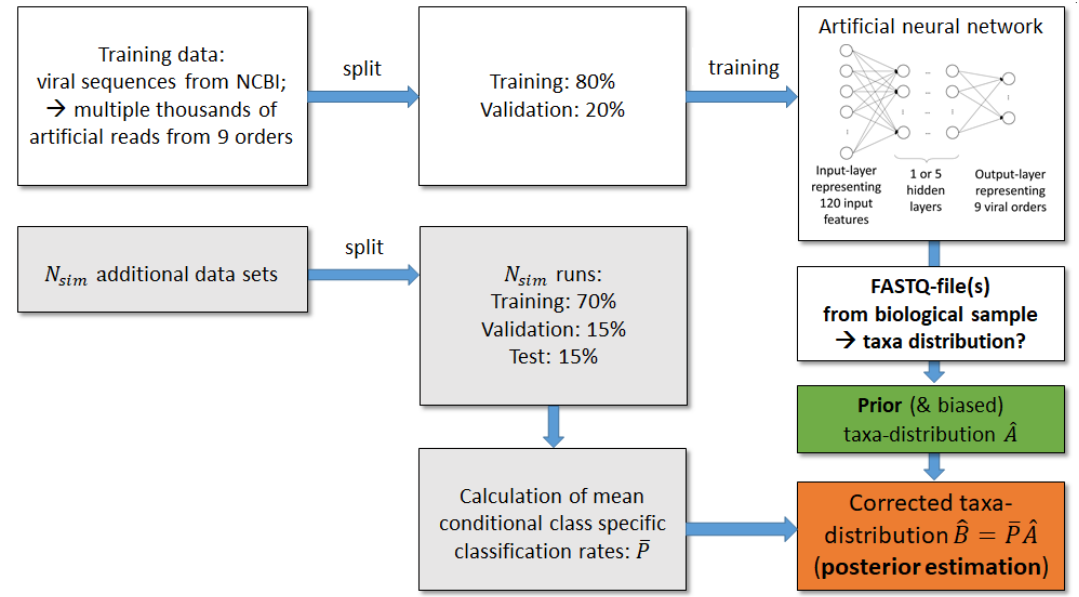
Figure 2. Workflow of estimating taxa distribution from a biological sample. Each ANN was trained with artificial viral sequencing reads drawn from viral reference genomes of the NCBI database. In order to train the parameters of each ANN, these sequences were split into 80% training and 20% validation data. The trained ANN model was applied to the reads of the FASTQ file from the biological sample to obtain a prior taxa distribution ˆ A . To correct this biased taxa distribution, simulation runs on N sim additional auxiliary data sets were performed (grey boxes). Misclassification rates from the additional simulations are taken to correct the prior estimation of frequency